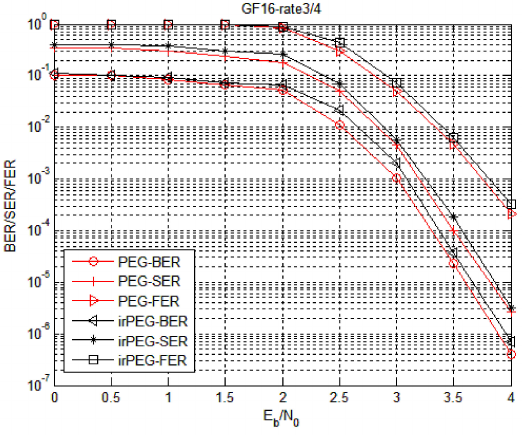
Figure 6. The error correction performance of irPEG algorithm in